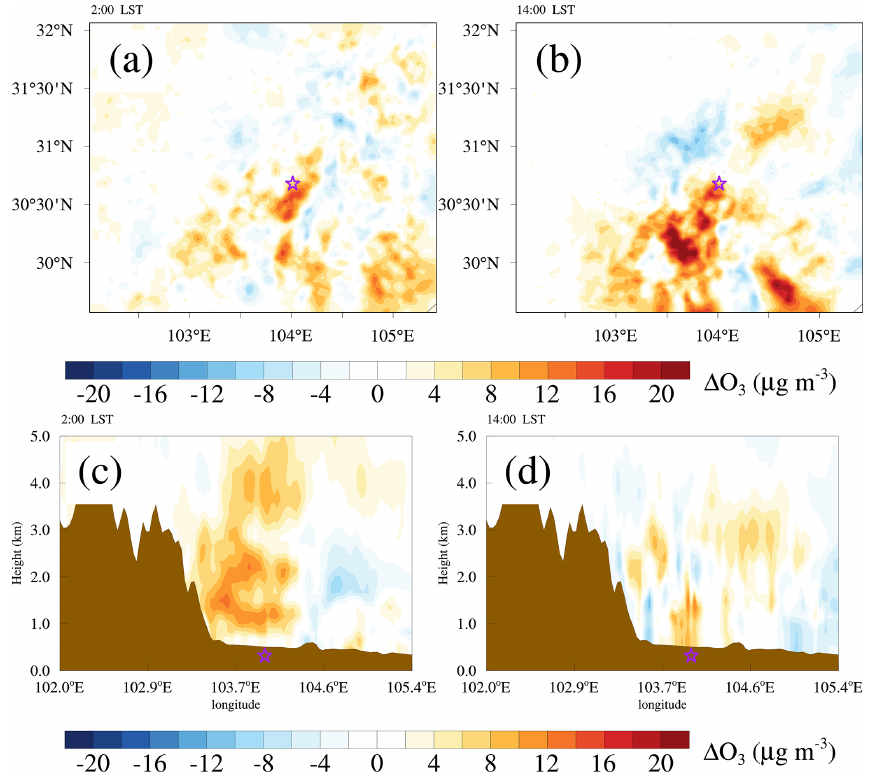
Figure 10. Panels (a) and (b) present the horizontal distributions of the differences in O 3 at the lowest model level at 02:00 and 14:00LST, respectively. Panels (c) and (d) present the east–west vertical cross sections of the difference in O 3 at 02:00 and 14:00LST, respectively. Purple stars show the location of Chengdu. Brown shaded areas represent the terrain. These results are the difference between the monthly average of the July_Base and July_noCD simulations (July_Base minus